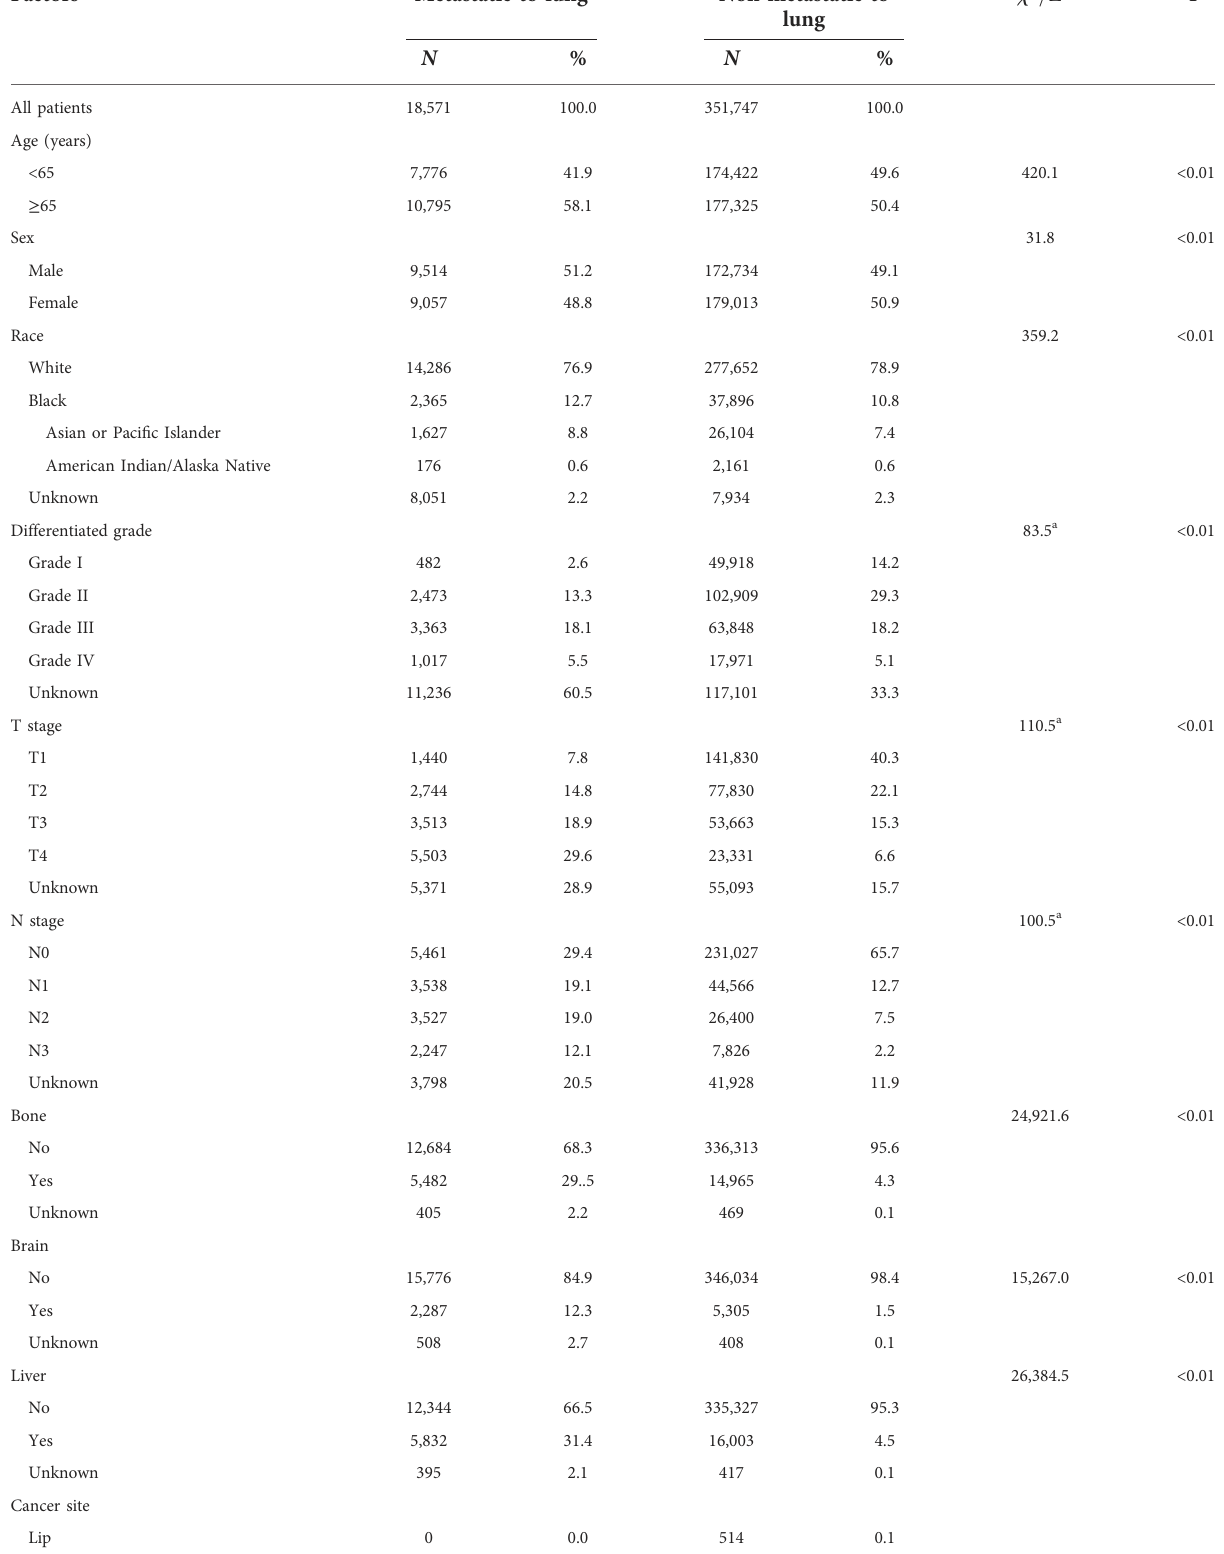
TABLE 1B Demographic and clinical characteristics distribution of the included patients in the validation